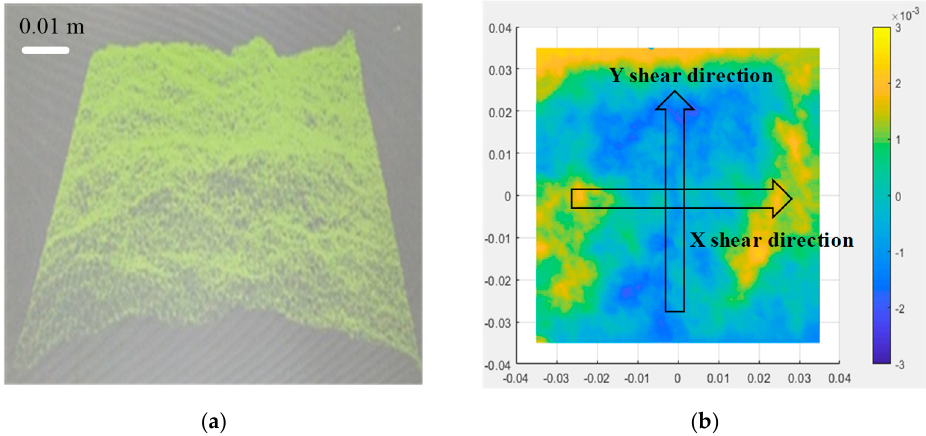
Figure 4. 3D topography point cloud images of rock fracture: ( a ) Initial image; ( b ) Reconstructed image.